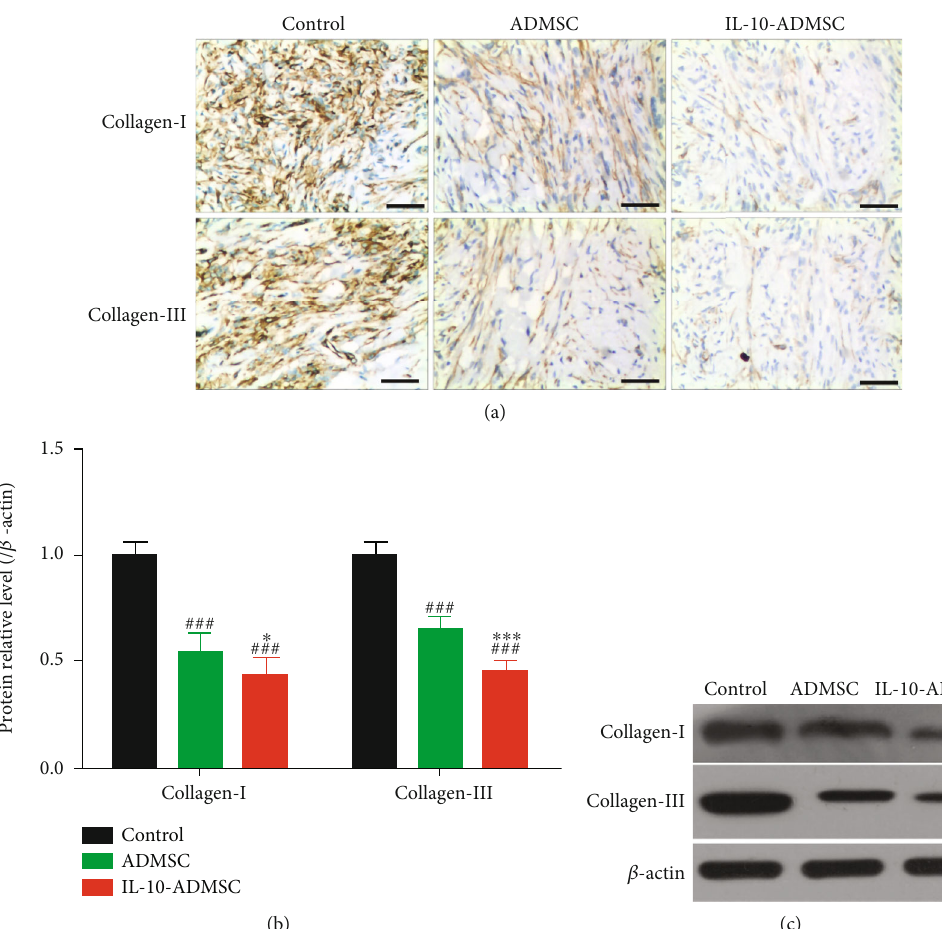
Figure 7: IL-10-modi fi ed ADMSC inhibited the expression of collagen I and III in wound. (a) After 7 days of treatment in di ff erent ways, we detected the expression of collagen I/III protein in wound using immunochemistry; (b, c) After 7 days of treatment in di ff erent ways, we detected the expression of collagen I/III protein in wound using immunoblotting. n = 6 ; scale bar: 50 μ m. Data was expressed as ( SD ± mean ); P value was calculated by one-way ANOVA; ∗ was P < 0 : 05 and ∗∗∗ was P < 0 : 001 vs. ADMSC group; ### was P < 0 : 001 vs. control